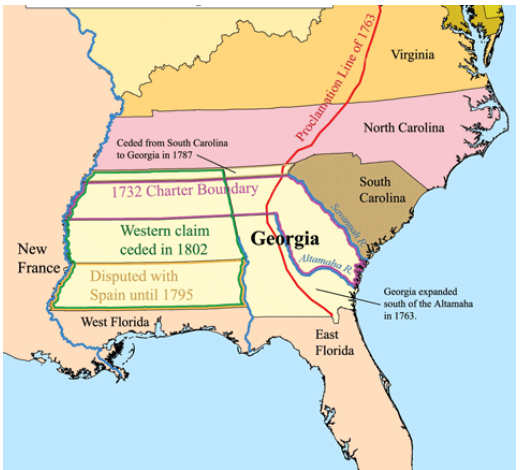
Figure 7. Virginia, North Carolina, South Carolina, and Georgia, circa 1763 to circa 1795. William A. Allen was born in Virginia, moved to South Carolina as a young adult, and then settled in Georgia when in his thirties. He lived for more than 50 years in Walton and Morgan counties in northeast Georgia (Figures 1 and 2 above). Allen and his family likely traveled the route known as “The Upper Road”, which extended east of the Proclamation Line of 1763. This route passed through Amelia Court House, a few miles from where Allen was reared in northwestern Amelia County, through Charlotte, North Carolina. From there, it crossed near the boundary between Greenville and Laurens Counties in South Carolina and entered northeastern Georgia. It passed through Morgan County en route to its terminal point near Macon in central Georgia. (“Map of the colonies with the proclamation line of 1763 shown in red”, by Kmusser, CC BY-SA 2.5,